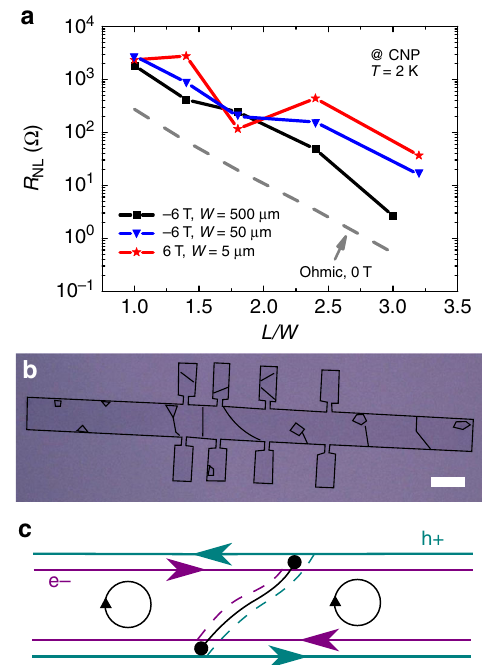
Fig. 4 Origin of nonlocal resistance for the CVD graphene samples. a Nonlocal resistance as a function of aspect ratio of the Hall bars for the 5-, 50-, and 500- μ m-wide samples, at CNP and 2 K. b Optical image of the microscale CVD graphene sample during the fabrication marking the visible grain boundaries and bilayer islands. White scale bar is 5 μ m. c At the CNP, and under an external fi eld, the counter-propagating edge currents are coupled to the charge of the carrier via Zeeman interaction. The presence of hole/electron asymmetric grain boundaries shunting the edge states through the insulating bulk leads to nonlocal measurements that are sensitive to the sample topology and sign of the magnetic fi